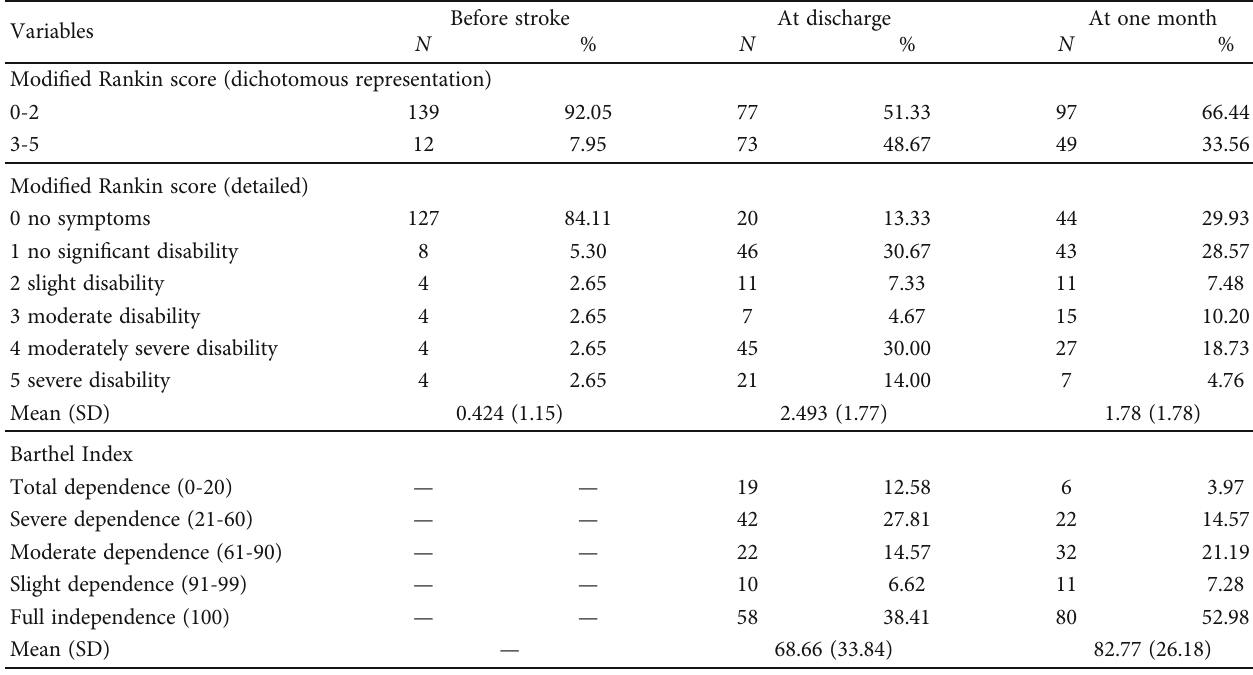
Table 3: Disability and functional